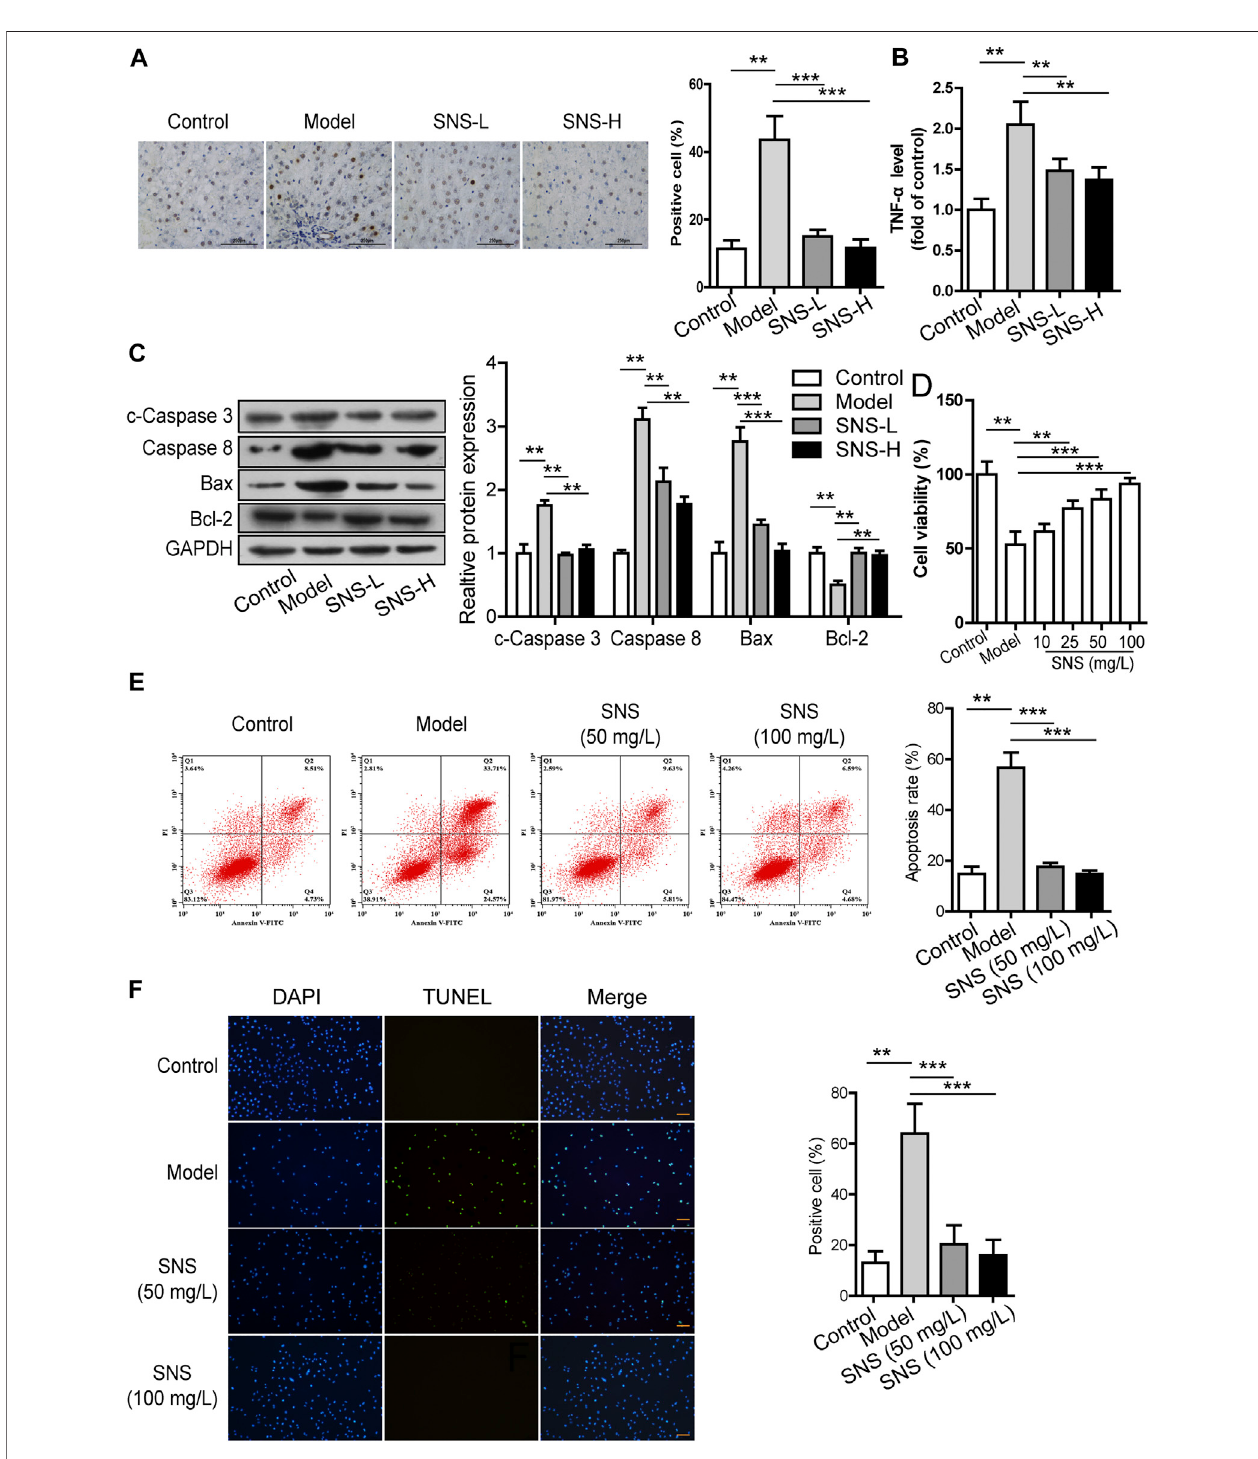
FIGURE 7 | SNS protects hepatic parenchymal cells from apoptosis in vivo and in vitro . (A) TUNEL staining (100 × ) of liver tissues. (B) Effect of SNS on the TNF- α levelinlivertissue. (C) EffectsofSNSoncleavedcaspase3,caspase8,Bax,andBcl-2inlivertissue. (D) EffectsofSNSonviabilityofL02cellsstimulatedwithTNF- α and ActD. (E) EvaluationofapoptosisofL02cellstreatedwithSNS andTNF- α /ActDusingtheMuseAnnexin VandDeadCellAssay. (F) EvaluationofapoptosisofL02cells treated with SNS and TNF- α /Act D via TUNEL staining. Data are presented as mean ± SD ( n (cid:2) 6). * p < 0.05, ** p < 0.01, *** p ＜ 0.001 compared to control or model